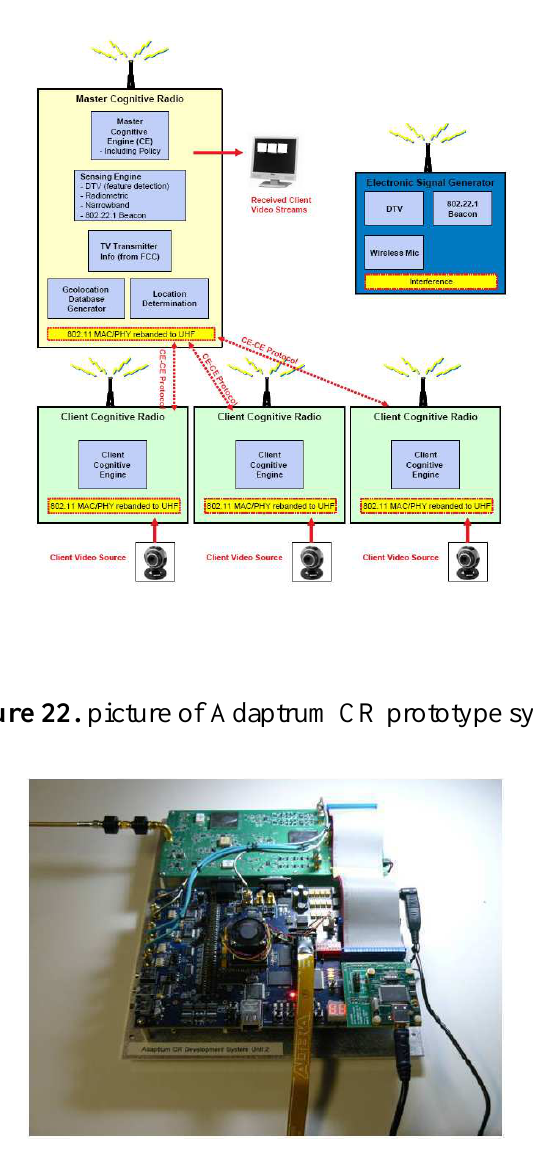
Figure 21. Motorola TV white space cognitive radio demonstration architecture.